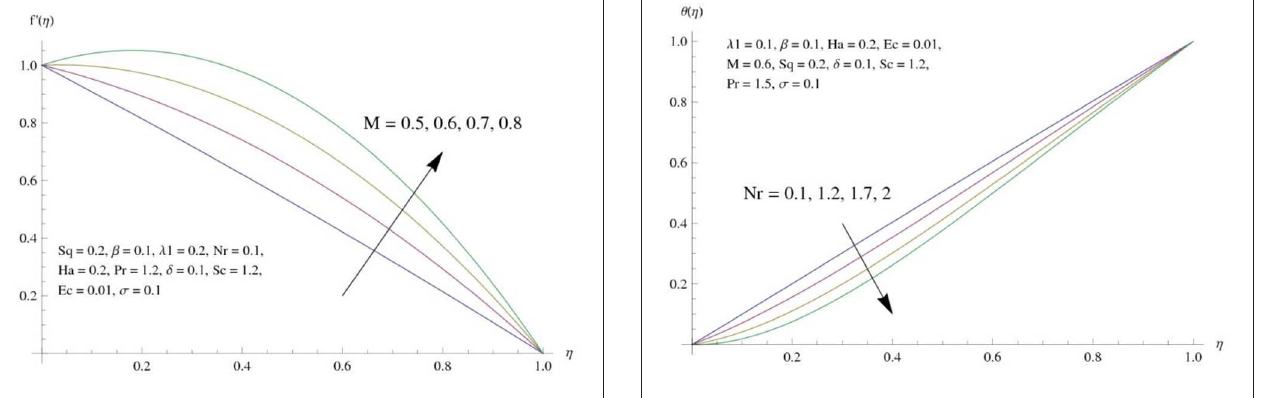
FIGURE 9 | Behavior of N r on θ ( η ).